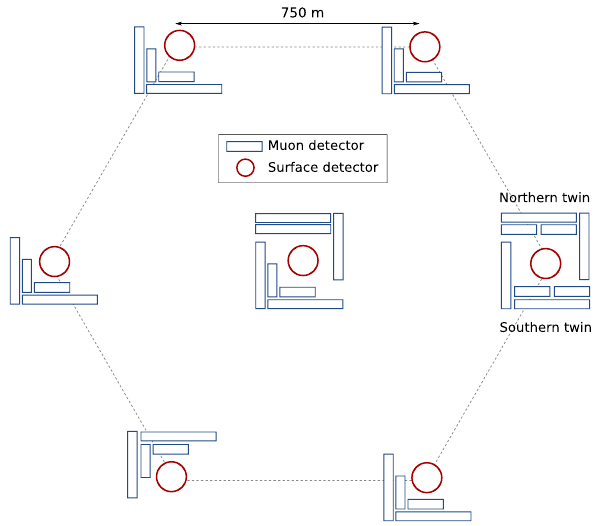
Fig. 1 Sketch of the underground muon detector engineering array. The circles represent the water-Cherenkov detectors. The muon coun- ters are symbolized by the